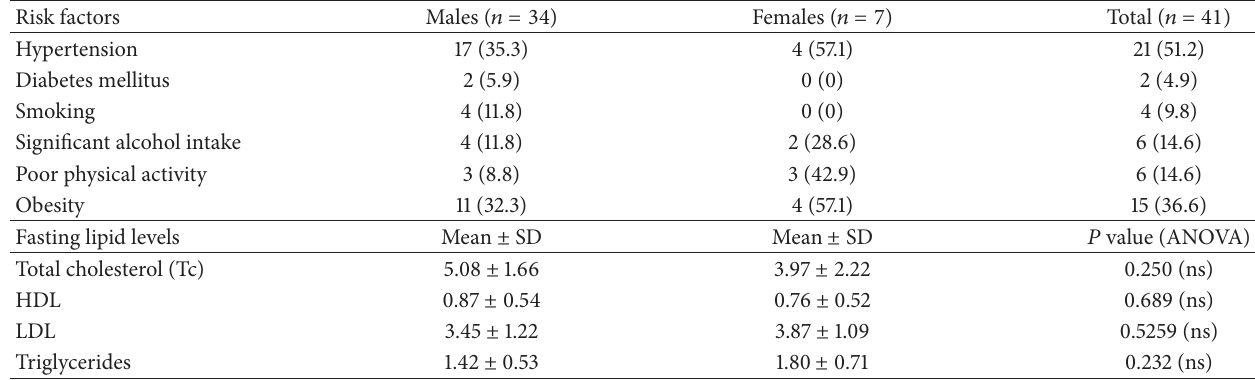
Table 4: Clinical and biochemical characteristics of clinical